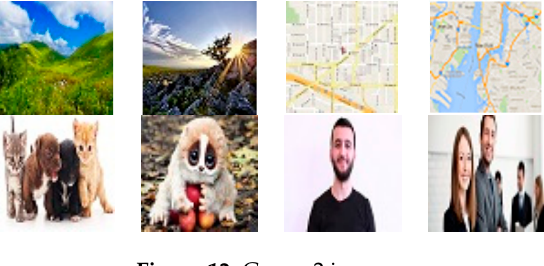
Figure 12. Group 2 images.